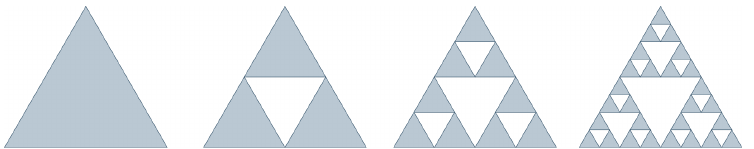
Figure 1. Illustration of a fractal triangle in 2D with increasing recursive depth of 0 to 3 (left to